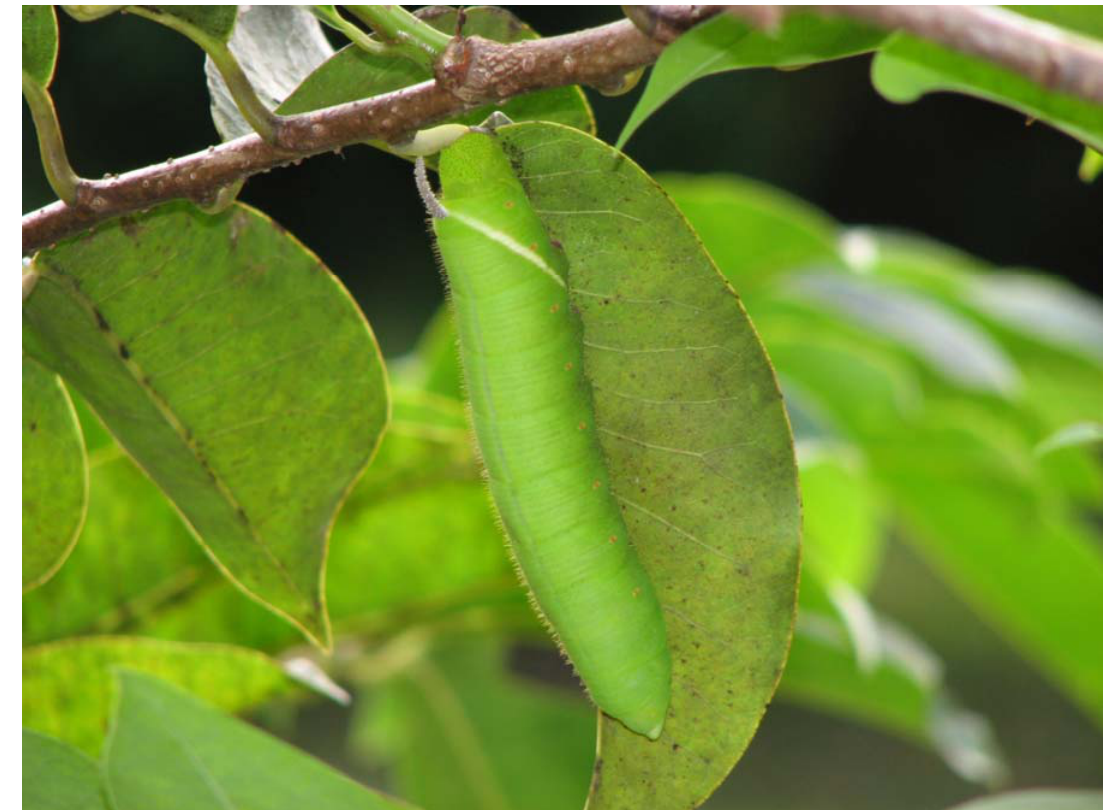
Figure 2 . Green sphingid larva on Annona glabra (Annonaceae) MNCR-Z3760. Photo: Guillermo